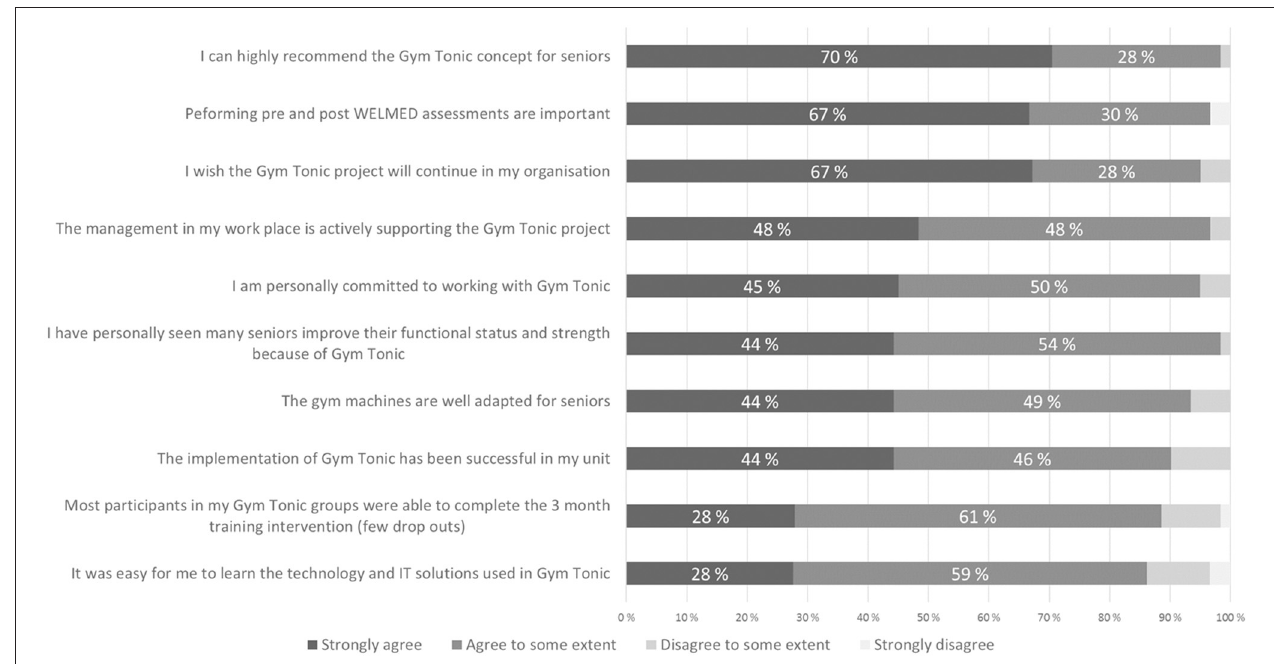
FIGURE 4 | Implementation questionnaire. Staff responses of those trained in Finland for Gym Tonic ( N = 40) and those trained locally for Gym Tonic ( N =